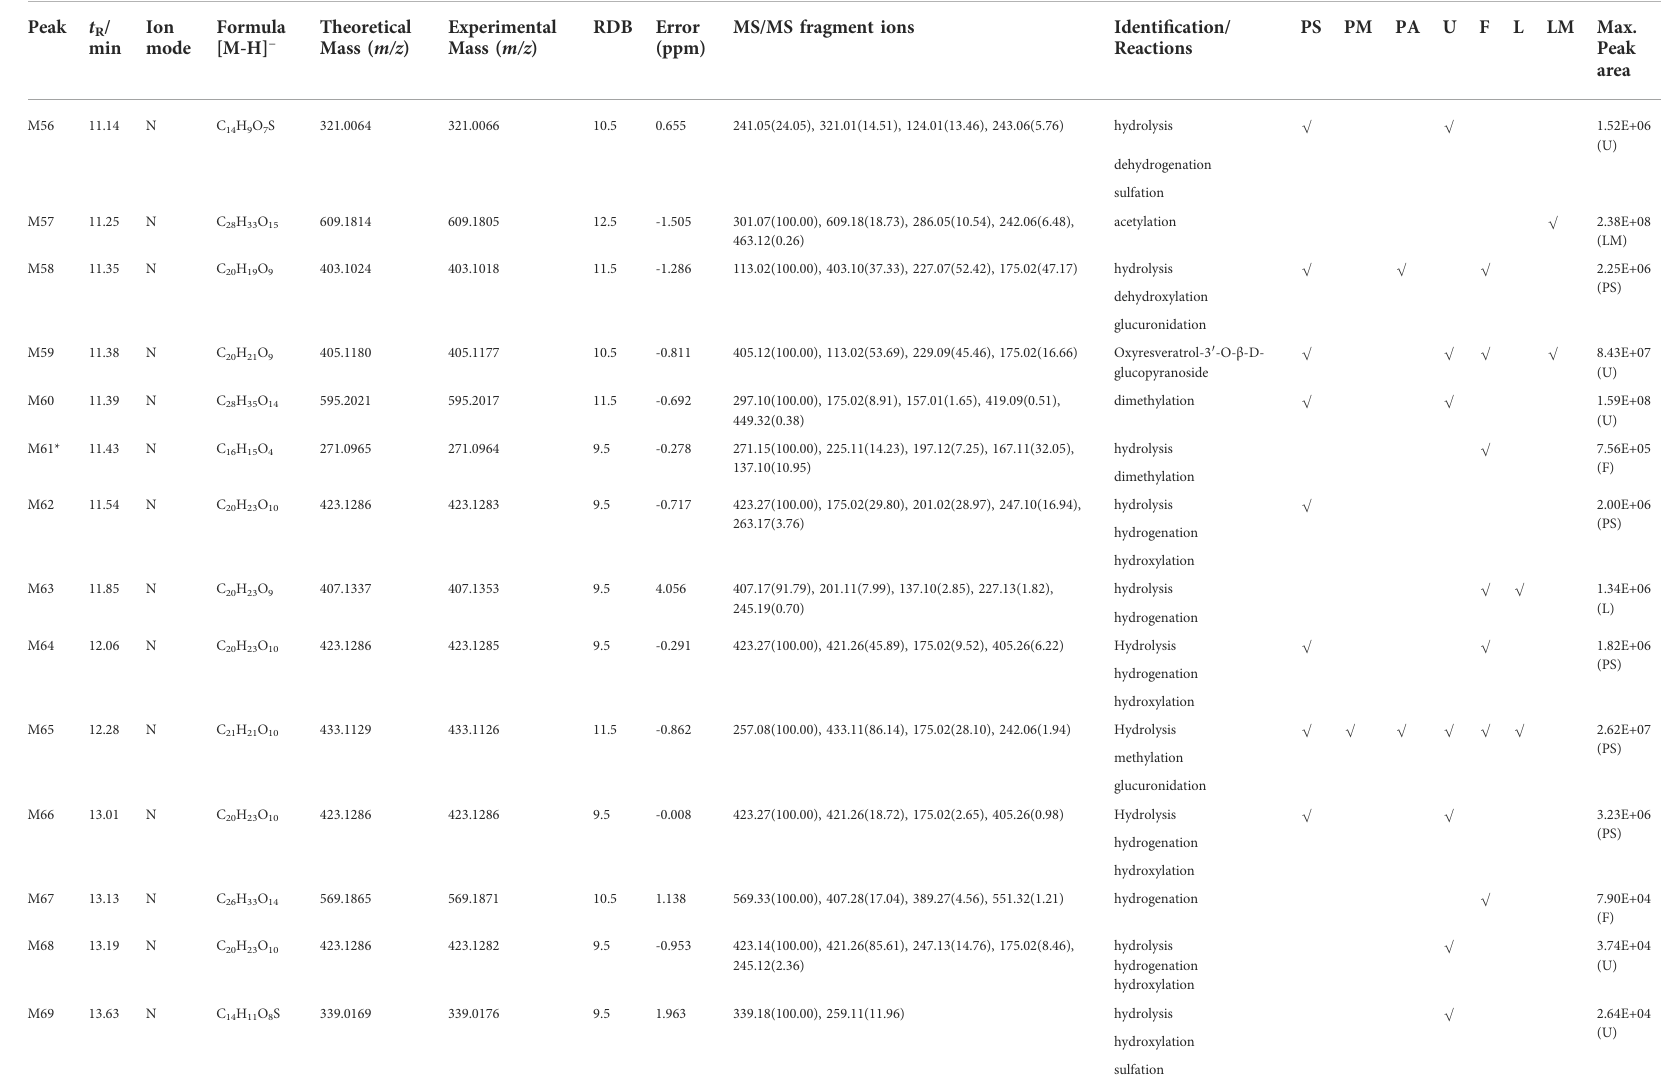
TABLE 1 ( Continued ) Summary of mulberroside A metabolites in vivo and in vitro of